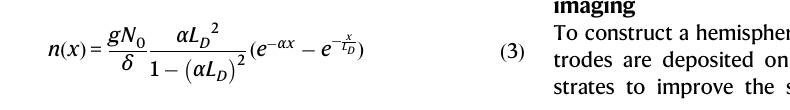
(Fig.3f).TheelectronsmobilitywasmeasuredinthePEA 2 FA 3 Pb 4 I 13 fi lm of 6.52×10 − 5 cm 2 V − 1 s − 1 (Supplementary Fig. 7d). The L D describes the